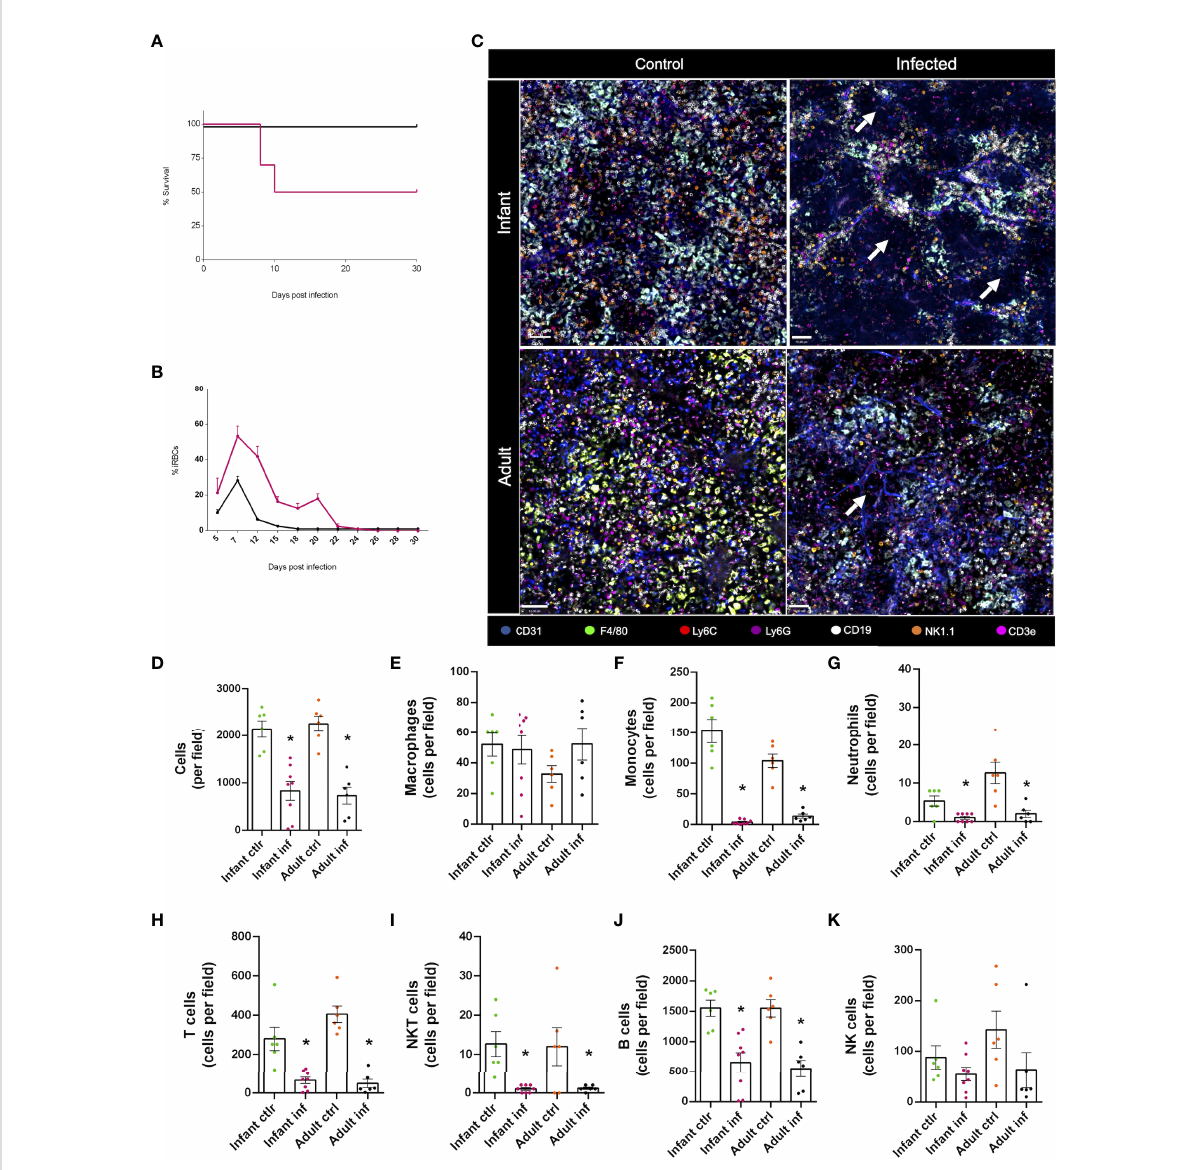
FIGURE 8 Major alterations in different subtypes of leukocytes, along with a profound reorganization of the spleen immune environment, is observed during acute malaria response. Infant (3-week-old) and adult mice (8-week-old) were infected with a murine model of malaria - Plasmodium chabaudi – and data was collected following disease progression. Intravenous infection with 1x10 5 infected red blood cells (iRBCs). (A) Survival rate of the infected animals in both groups (infants and adults). (B) Percentage of iRBCs in the blood of the tested animals. (C) Confocal microscopy images of the spleen from both control and infected animals showing vasculature (anti-CD31, in blue), macrophages (anti F4-80, in green), monocytes (anti- Ly6C, in red), neutrophils (anti-Ly6G, in purple), B lymphocytes (anti-CD19, in white), NK cells (anti-NK1.1, in orange) and T lymphocytes (anti-CD3e, in magenta). (D-K) Differential expression of markers and cell morphology were analysed to quantify immune cell populations in control and infected animals, both in infant and adult groups. *p <0.05 compared to the control group. t -test. NK, natural